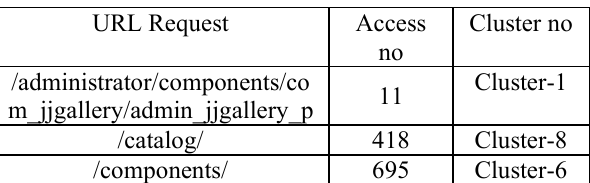
Table 9. Allocating URL request to each cluster